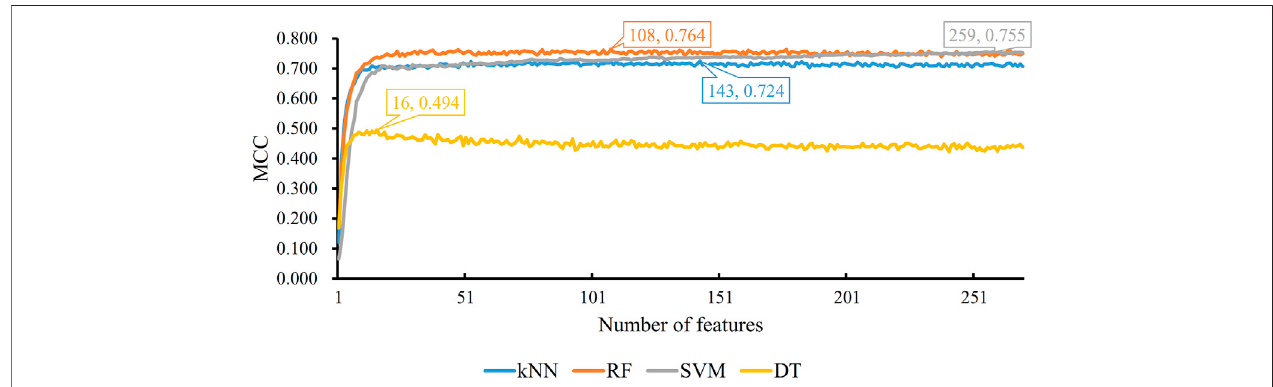
FIGURE 6| IFS with four classi fi cation algorithms on mRMR feature list of PseAAC features. The highest MCC values obtained by four classi fi cation algorithms are 0.724, 0.764, 0.755, and 0.494, respectively.